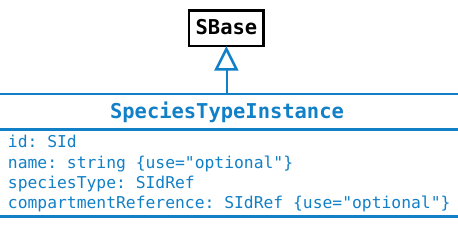
Figure 5: The definition of the SpeciesTypeInstance